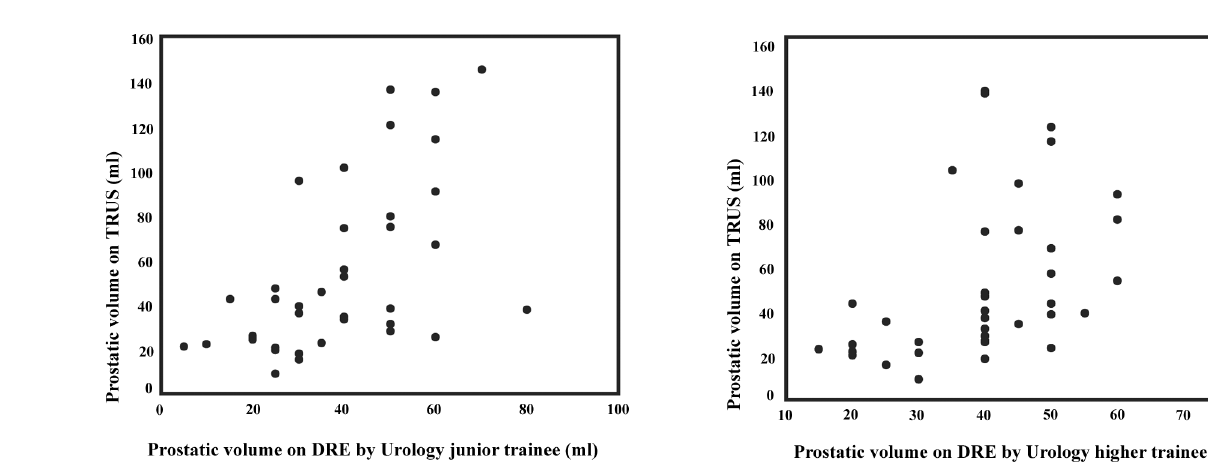
Figure 2 – Scatter plot of transrectal ultrasound (TRUS) volume and digital rectal examination (DRE) volume for urology higher